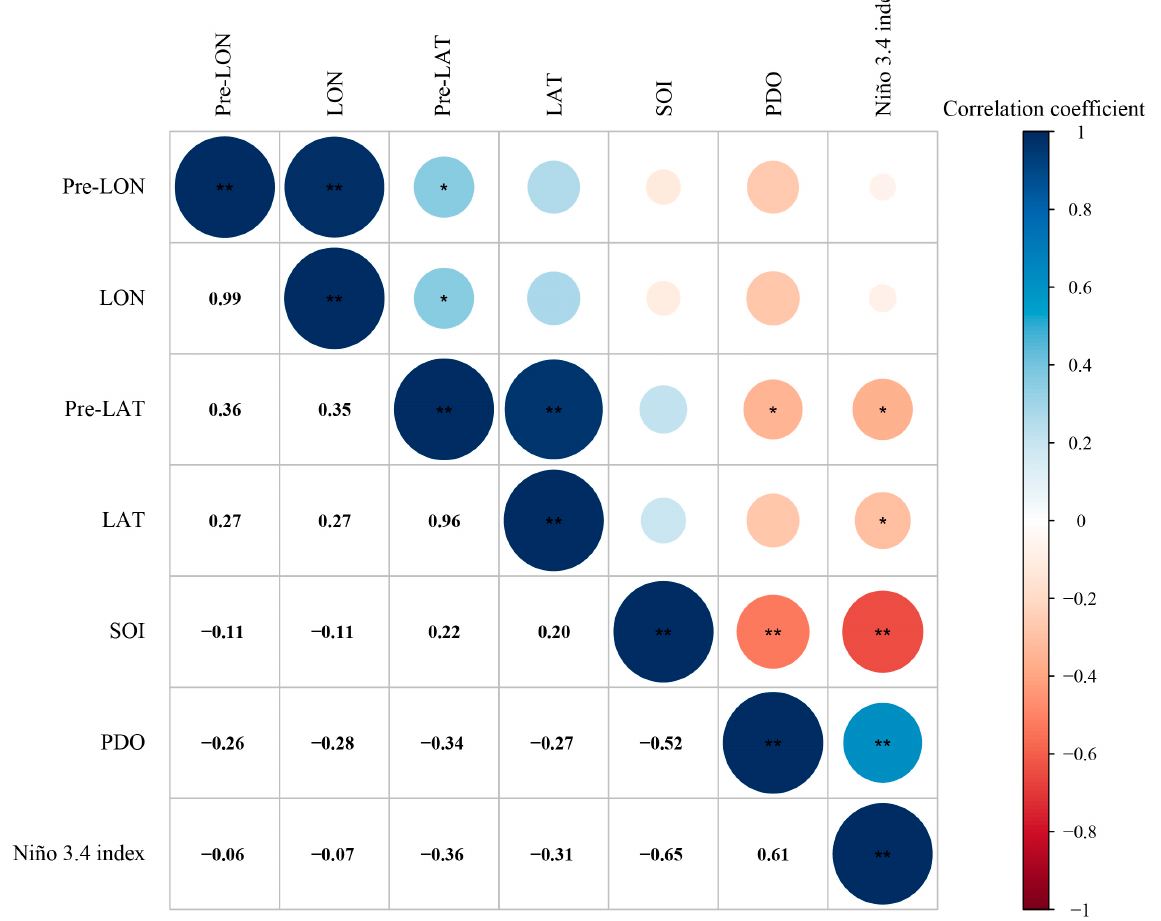
Figure 5. Correlation analysis of anomalous climatic events with the latitude and longitude of the monthly center of gravity (LON refers to the longitude of the center of gravity, LAT refers to the latitude of the center of gravity, Pre-LON refers to the longitude of the predicted center of gravity, and Pre-LAT refers to the latitude of the predicted center of gravity). * p < 0.01, a statistically significant correlation. ** p < 0.001, a highly statistically significant correlation.